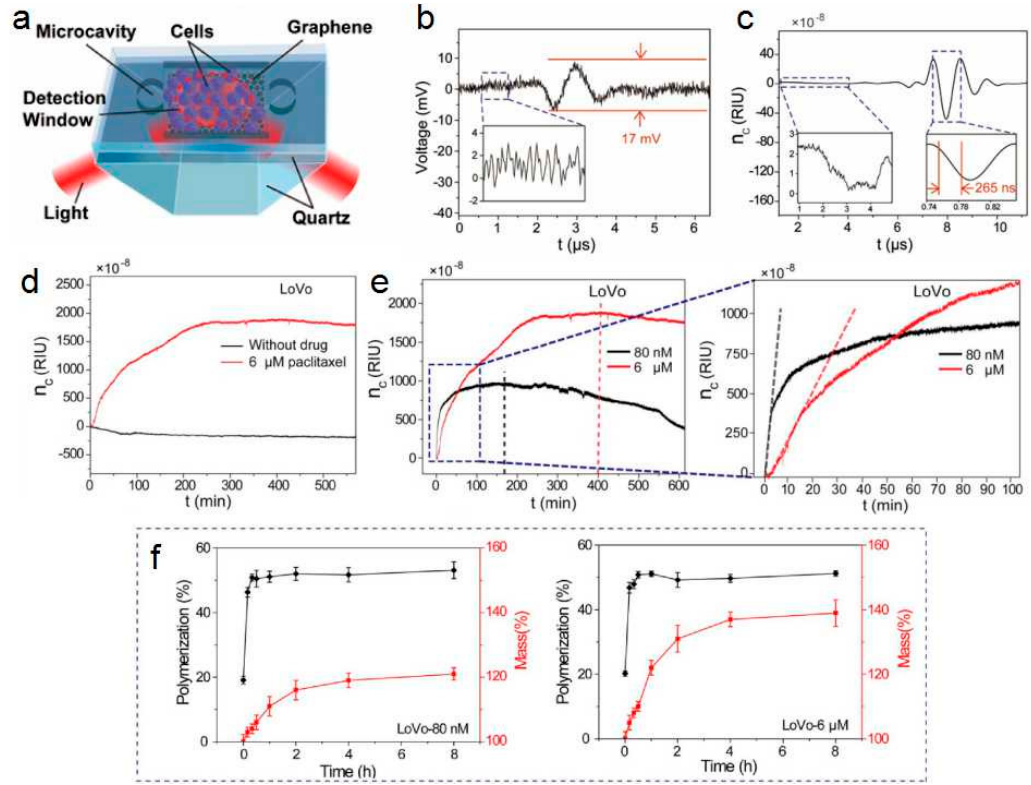
Figure 7. ( a ) Schematic and principle of graphene-based optical biosensor (GOB) sensing. ( b ) The direct detection of a weak RI change generated by an ultrasonic wave. ( c ) The response time of the GOB. ( d ) Detection of cancer cell responses to paclitaxel. ( e ) The time-resolved RI changes in LoVo cells with 80 nM and 6 µ M paclitaxel solution. The right is an enlarged image of the left, and the slope analysis of the initial responses. ( f ) Tubulin polymerization and total mass analysis of LoVo cells treated with paclitaxel at different time points. Reproduced from [80] with permission of the Sensors and Actuators B.